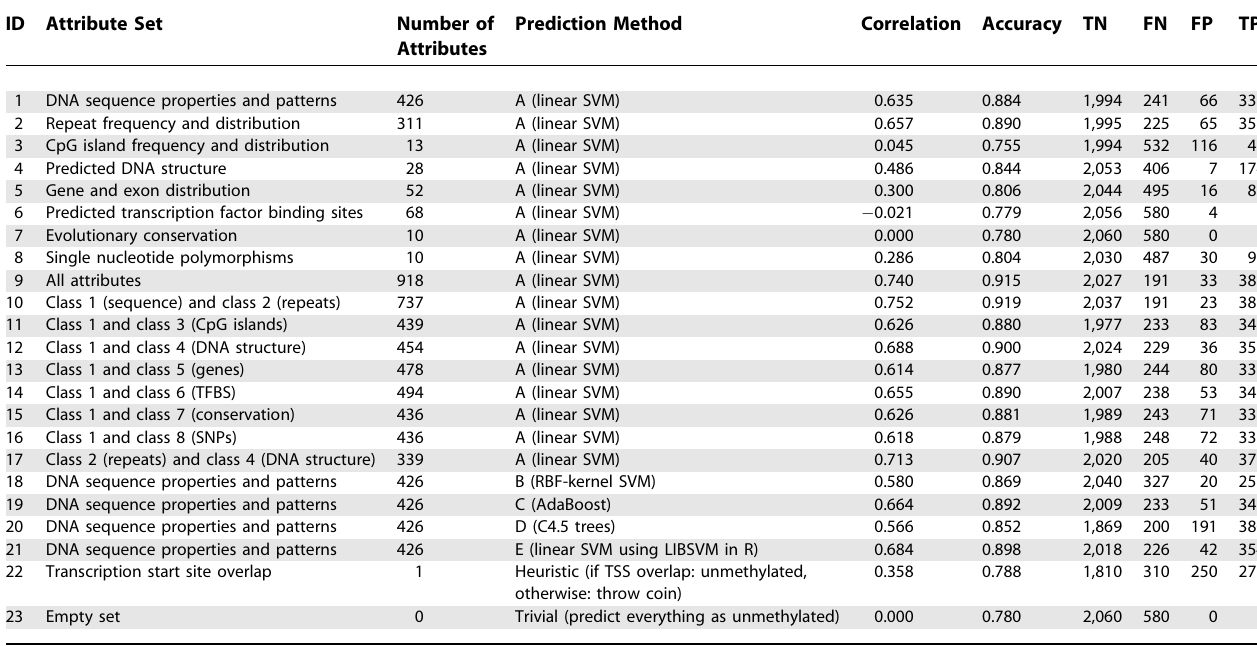
Table 2. The Predictive Power of Attribute Classes Differs Remarkably; Control Experiments Confirm the Appropriateness of the Prediction